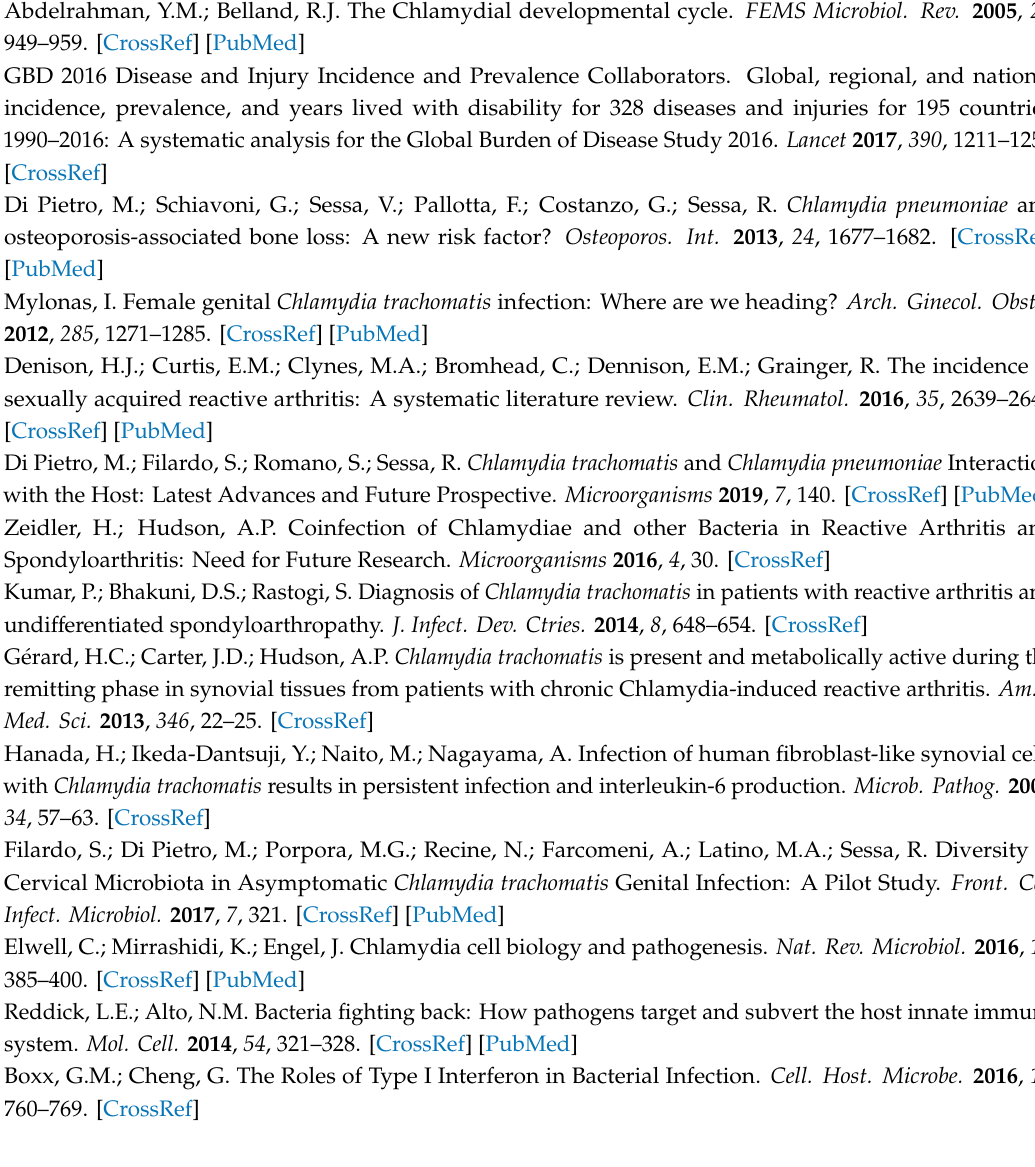
Figure S1: Cytotoxic activity of IFN α , IFN β and IFN γ on human primary synovial